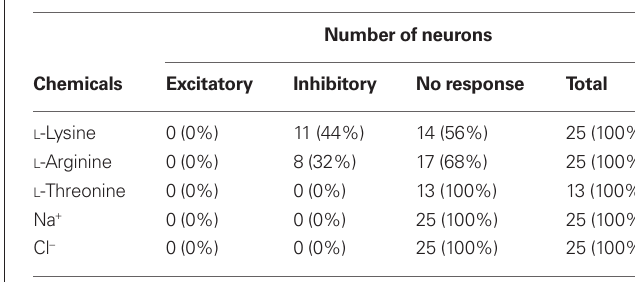
Table 2 | responsiveness of VMH neurons to microiontophoretically applied chemicals in awake